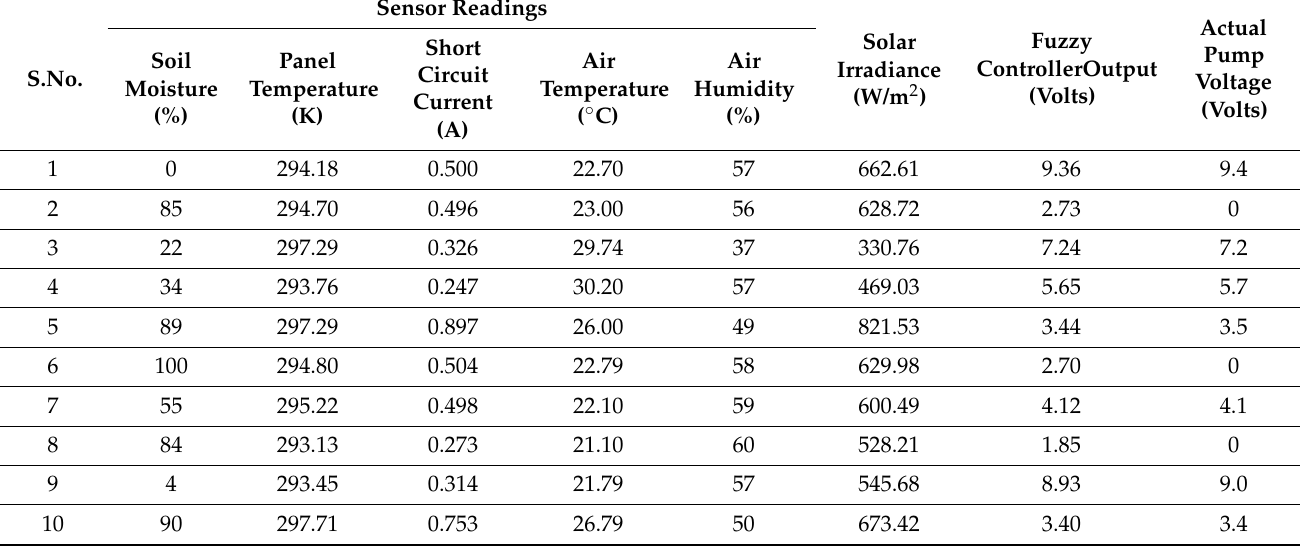
Figure 20. Working model of the system.